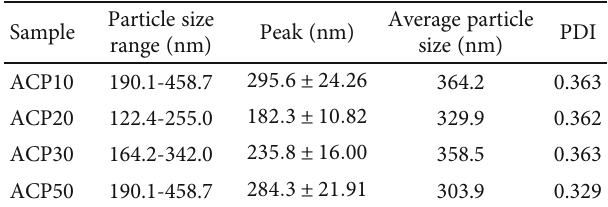
Figure 3: FE-SEM images of the AGN/CS/PP nanoparticles and PP samples at the magni fi cation of 50,000 times. Table 3: Average particle size of the AGN/CS/PP nanoparticles prepared with di ff erent PP contents.